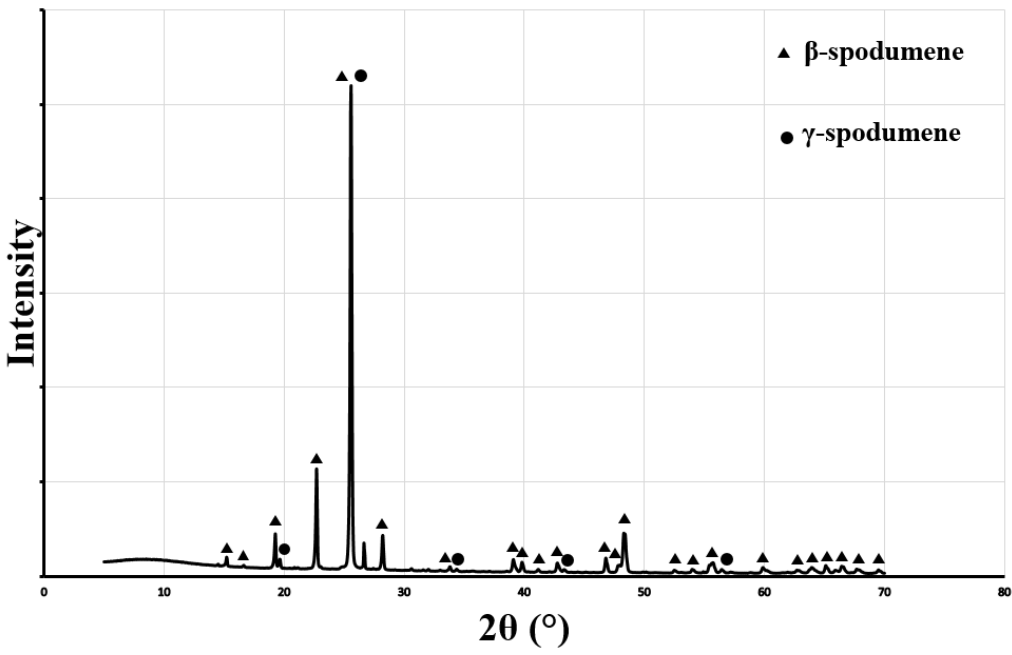
Figure 8. X-Ray pattern of a typical β-spodumene and γ-spodumene sample .